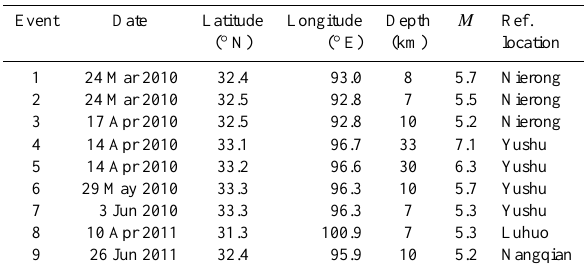
Table 2. Earthquake events in the selected area during analysis pe-